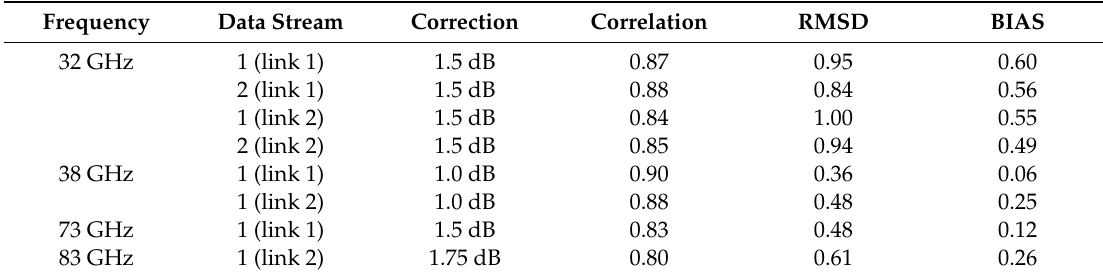
Figure 9. Average rain rate per 15 min derived from the signal link compared with the rain gauge measurement on 11 June 2017: ( a ) 32 GHz link; ( b ) 38 GHz link; ( c ) E-band link. Table 4. Accuracy analysis of rain retrieval from the three test links. RMSD BIAS